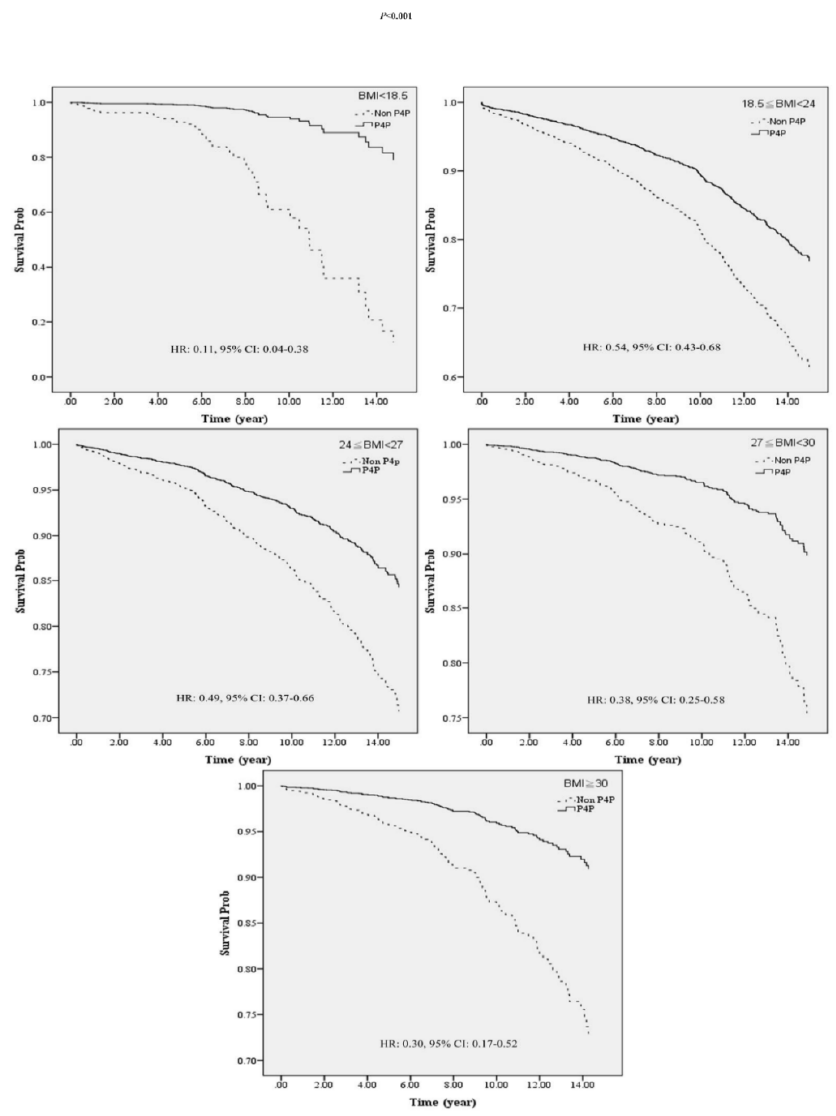
Figure 2. Stratified analysis was conducted to compare the differences in reducing the risk of death between P4P and non-P4P groups by BMI category.